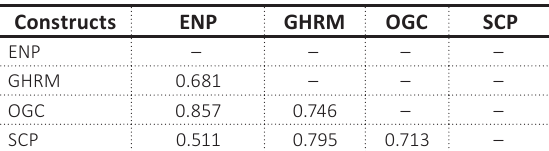
Table 3. Heterotrait-monotrait ratio (HTMT)